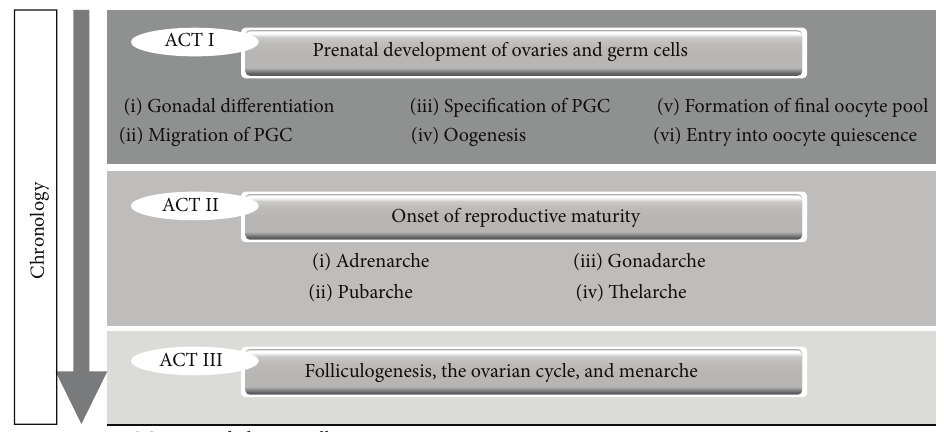
Figure 1: Main events in the physiologic life course of female reproductive function.